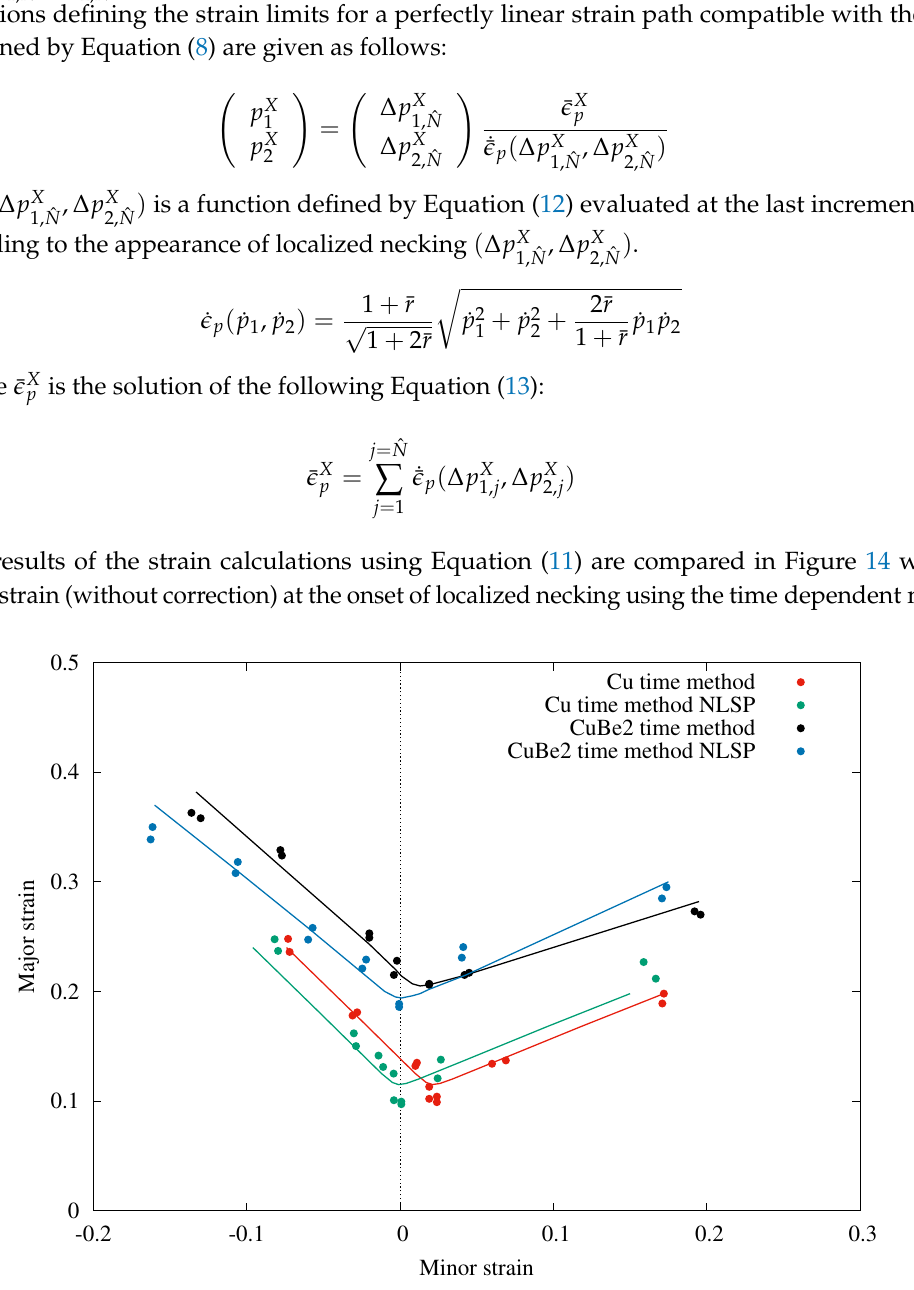
Figure 14. Process corrections for non-linear strain path effects (NLSP) in the Nakazima tests for the pure Cu and the CuBe2 alloy: strain limits are obtained with the time-dependent